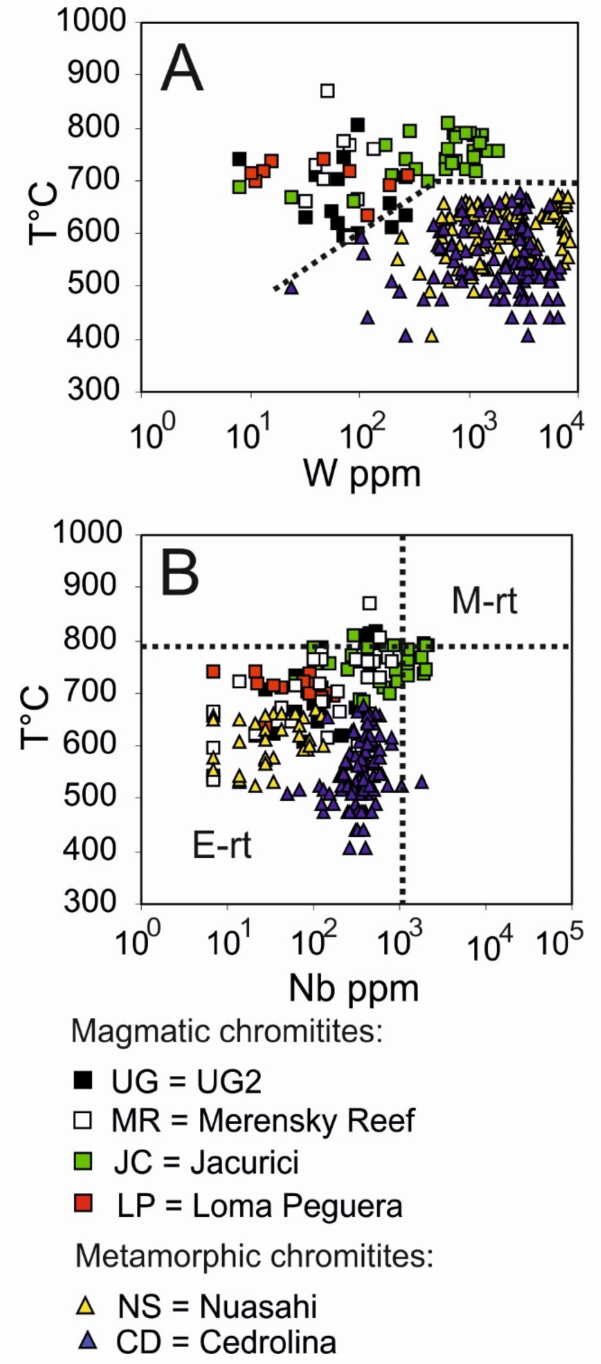
Figure 15. Correlation W-T ◦ C separates rutile in metamorphic chromitite from rutile in magmatic chromite, the dotted line marking the thermal gap ( A ). Projection of chromitite-rutile data in the Nb-T ◦ C diagram after [14] ( B ). The dotted cross separates the field of rutile crystallized directly from magmas (M-rt) from the field of rutile exsolved from chromite